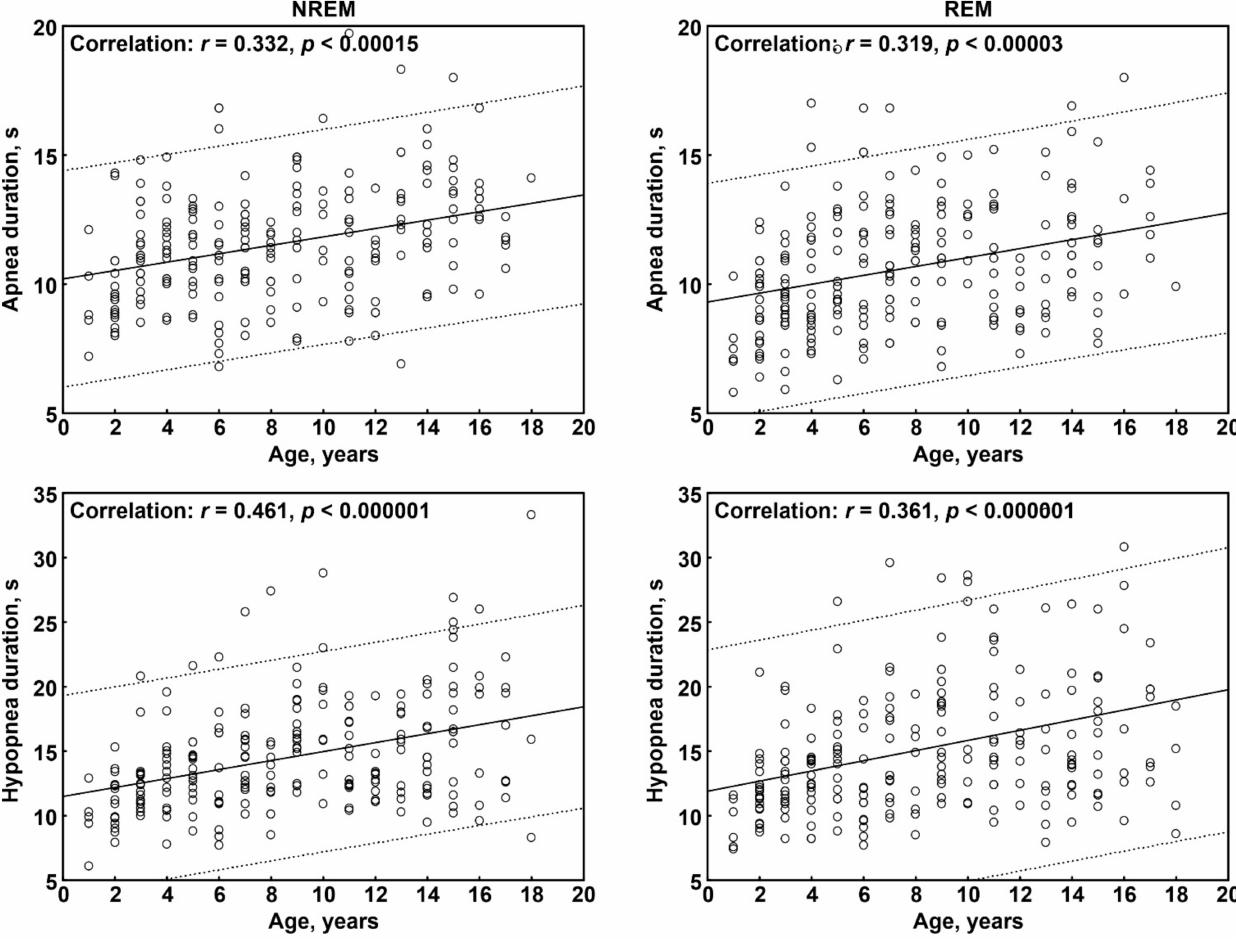
Figure 2. Correlation between age of participants and the respiratory event duration values considered in this study. The continuous line is the regression line, while the two dashed lines represent the limits of the area within which 95% of the points are expected.